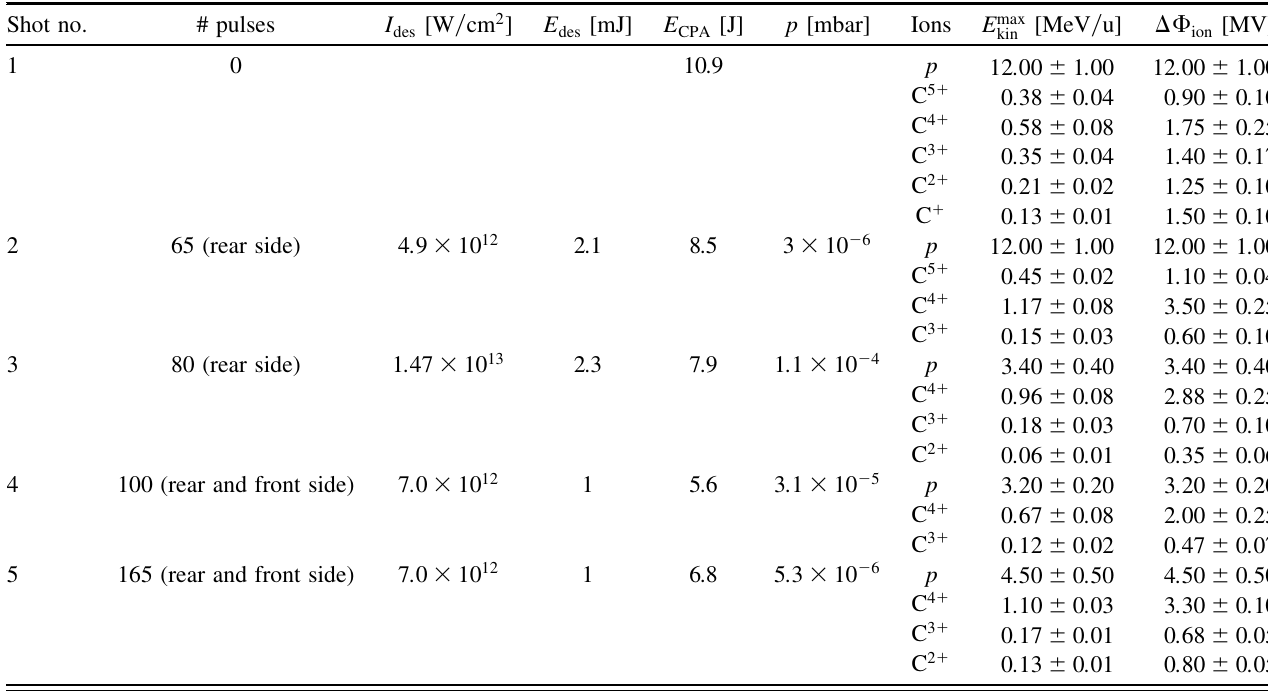
TABLE III. Overview of all important parameters of the discussed laser desorption shots and of the reference shot (no cleaning) on 10 (cid:1) m Au foils. The quantities listed here are the intensity I main pulse and the target chamber pressure p . Included are also the analyzed results from the Thomson parabola ion traces regarding the maximum ion kinetic energies E max i and a calculated estimate for the maximum potential difference (cid:1)(cid:2) ions should have experienced by the quasistatic electric